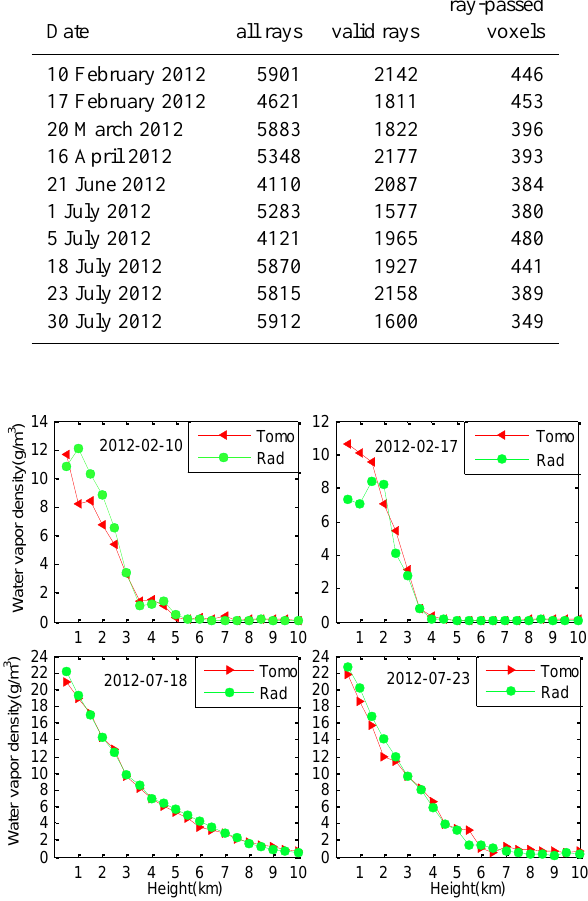
Fig. 9. Comparisons of water vapour densities obtained from to- mography (red line) and radiosonde data (green